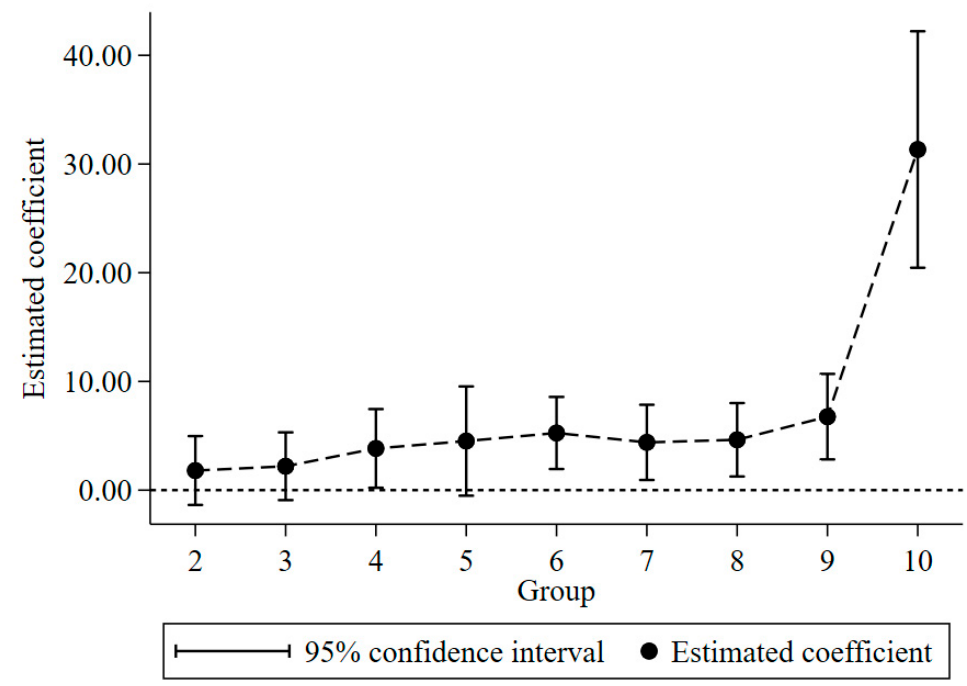
Figure 5. Estimated results of the second step of Model Ⅲ .